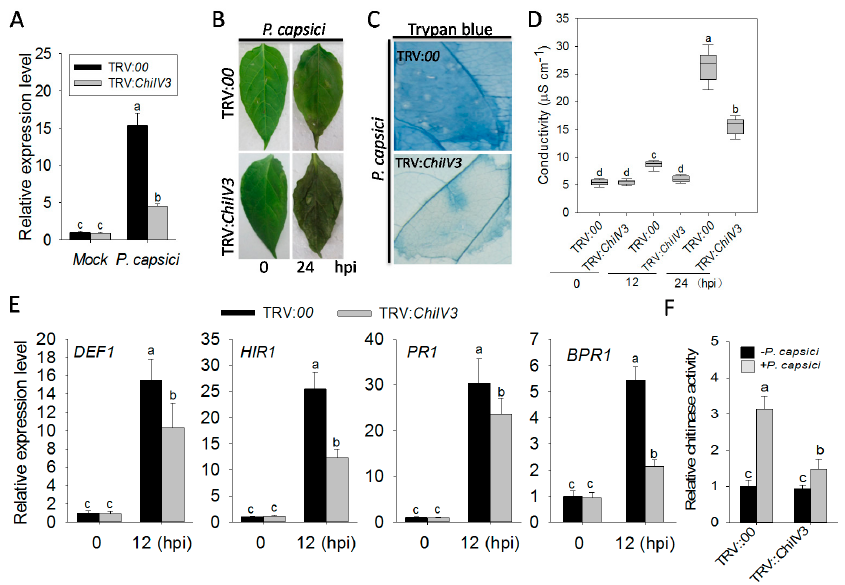
Figure 4. The silencing of ChiIV3 by virus-induced gene silencing (VIGS) enhanced the susceptibility of pepper to P. capsici inoculation. ( A ) Quantitative reverse transcription-PCR (qRT-PCR) analysis of the transcript levels of ChiIV3 in ChiIV3 -silenced pepper plants inoculated with P. capsici . The transcript level of ChiIV3 in the mock-treated pepper (ddH 2 O) leaves was set to “1”; ( B ) The disease symptoms of ChiIV3 -silenced pepper plants at 24 h after inoculated with P. capsici spores. Hpt, hours post inoculation; ( C ) Trypan blue staining and ( D ) conductivity measurement of ChiIV3 -silenced or unsilenced pepper leaves at 24 h post inoculation of 10 μ L P. capsici zoospores (OD 59 = 0.6). Photos were taken by a camera (Canon) at 24 hpi; ( E ) Determination of the transcript levels of defense-related marker genes in ChiIV3 -silenced or unsilenced pepper leaves at 12 hpi of P. capsici spores, compared to the untreated pepper plants. DEF1 , a pepper defensing gene in response to pathogen infection; HIR1 , a pepper gene encodes a hypersensitive induced reaction (HIR) protein; PR1, pathogenesis-related protein 1; BPR1 , the defense-related genes BPR1 (basic PR-1). The transcript level of all marker genes in unsilenced pepper plants without treatment was set to an expression value of “1”. Hpi, hours post inoculation; ( F ) The relative chitinase activity of ChiIV3 -silenced or unsilenced pepper plants at 24 hpi of P. capsici spores. The chitinase activity of unsilenced pepper plants treated with buffer (mock) was set to 1. ( A , D , E ) Values are means ± SD ( n = 6). Different letters indicate significant differences determined by Fisher’s protected LSD test ( p < 0.05).